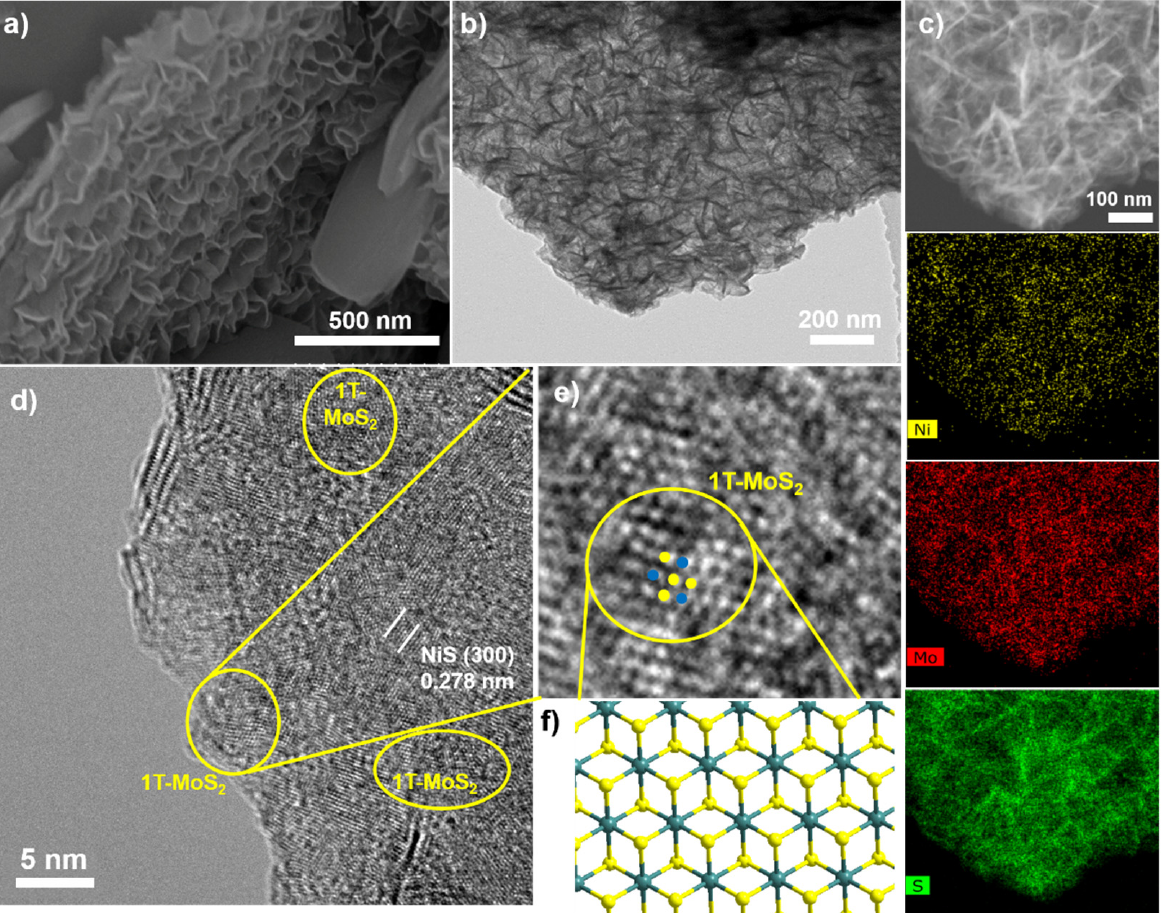
Figure 1. ( a ) SEM image, ( b ) TEM image and ( c ) STEM-EDX elemental mapping of the 1T-MoS 2 /NiS; ( d ) HRTEM image on the basal plane of 1T-MoS 2 /NiS and ( e , f ) zoom-in view of the selected regions and the lattice schematic of 1T-MoS 2 .